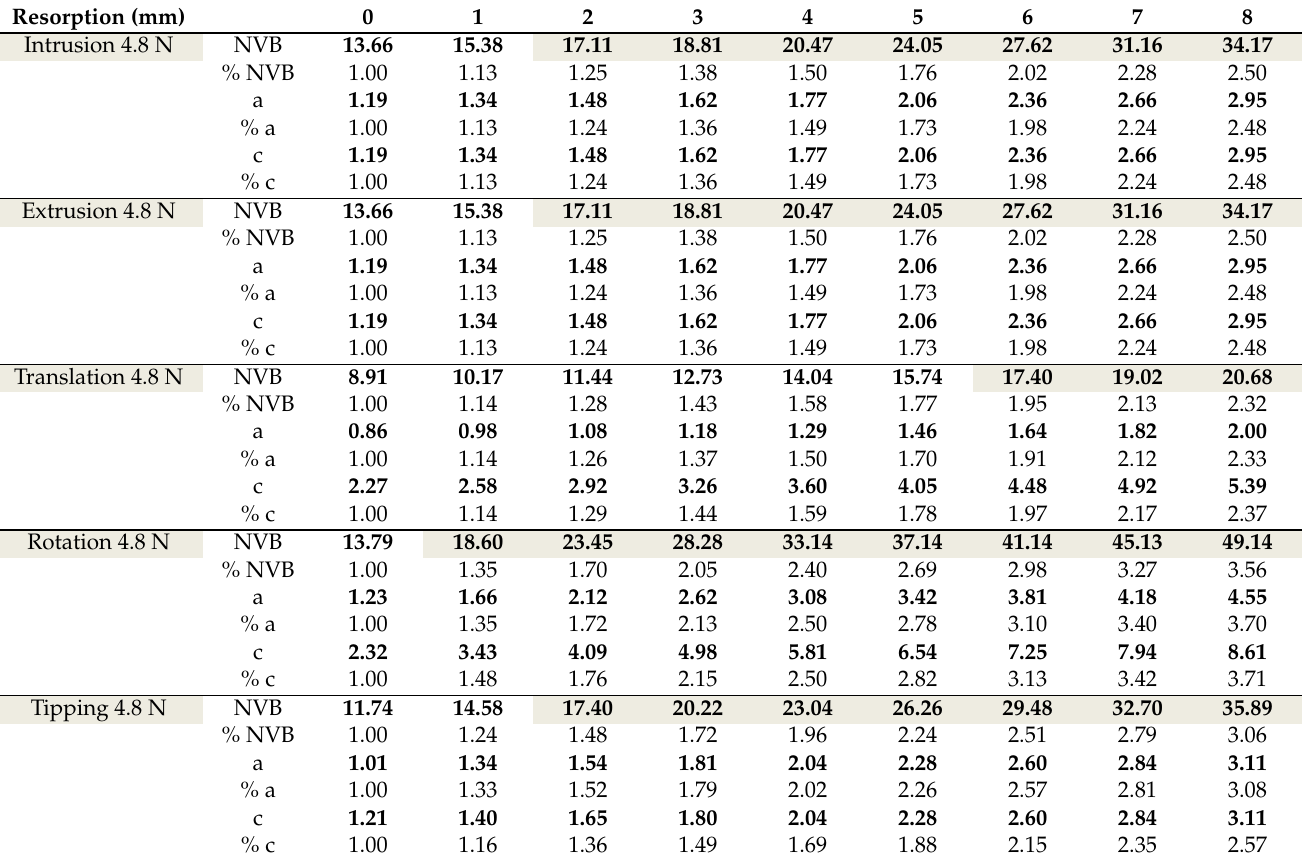
Table 5. The Tresca shear-stress average values (KPa) produced by 4.8 N of orthodontic